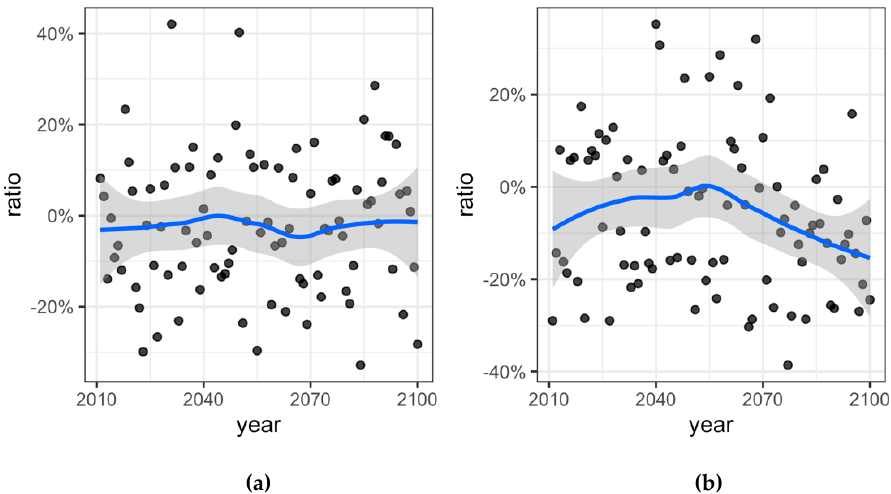
Figure 8. Ratio δ s of precipitation to the historical 30-years-mean annual on Greece for the scenarios: f ( a ) Representative Concentration Pathway (RCP)45 and ( b ) RCP85. Values are unitless. With blue are marked the smooth lines and with grey bands the standard error variance produced by means of Local Polynomial Regression Fitting